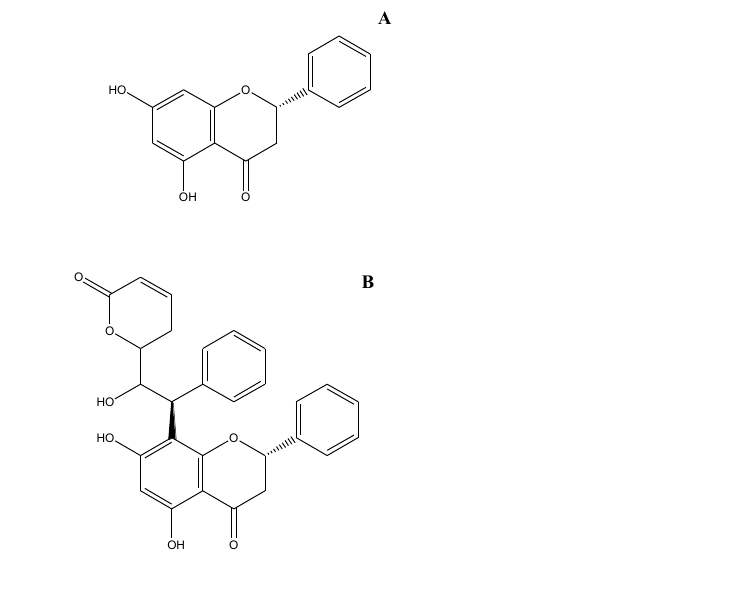
Figure 1. Chemical structures of goniolactone C and pinocembrin. ( A ) Goniolactone C. Molecular formula: C 28 H 24 O 7 ; molecular weight: 472.16. ( B ) Pinocembrin. Molecular formula: C 15 H 12 O 4 ; molecular weight: